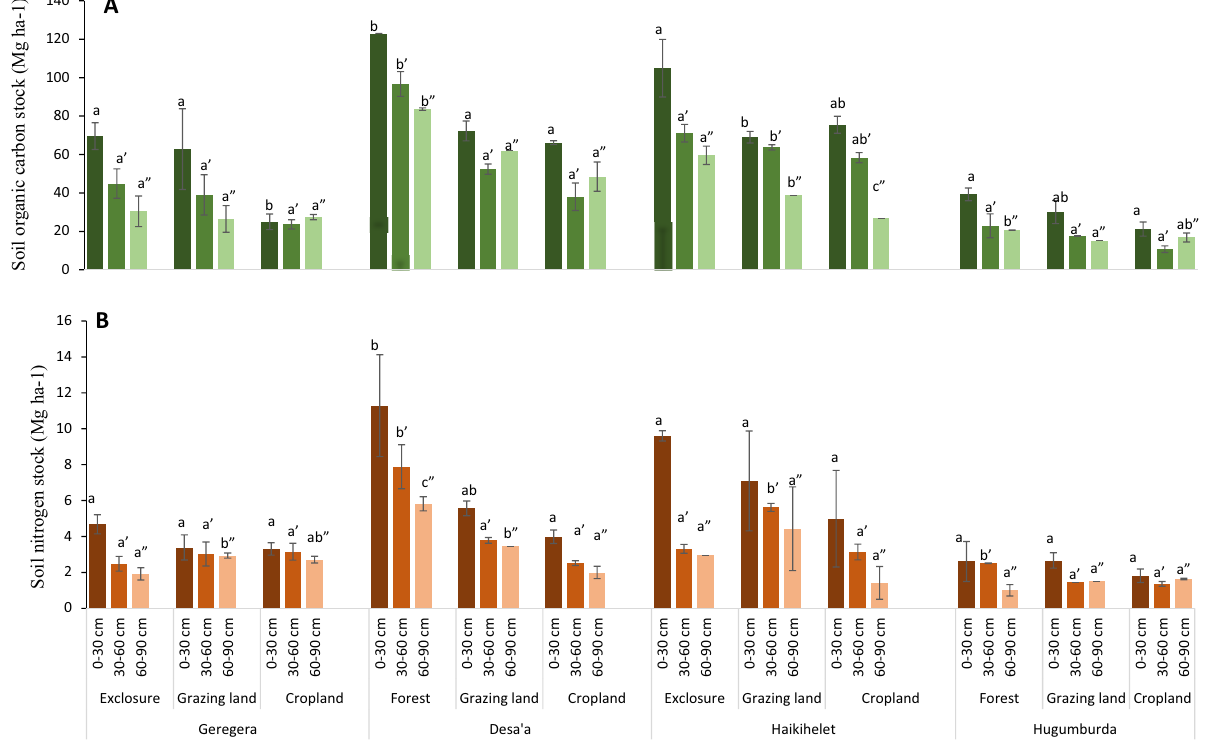
Figure 3. Soil organic carbon stock ( A ) and soil nitrogen stock ( B ) as influenced by land use and soil depth at Geregera, Haikihelet, Desa’a, and Hugumburda. Error bars represent the standard error of means. Letters above the error bars indicate significant differences ( p ≤ 0.05) between land uses at 0–30 cm (a), 30–60 cm (a ′ ) and 60–90 cm (a ″